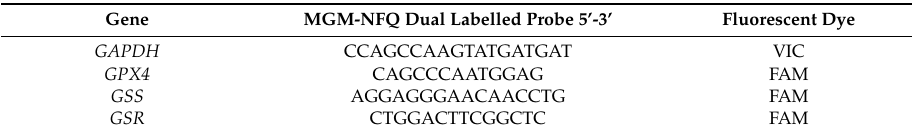
Table 3. Dual labelled probes for target and endogenous control genes. MGB-NFQ quencher was used in all